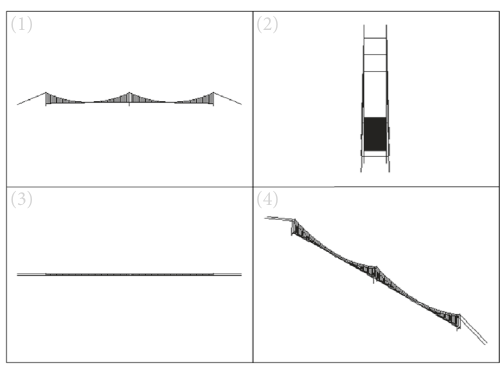
Figure 5: The 3D-FEM model of